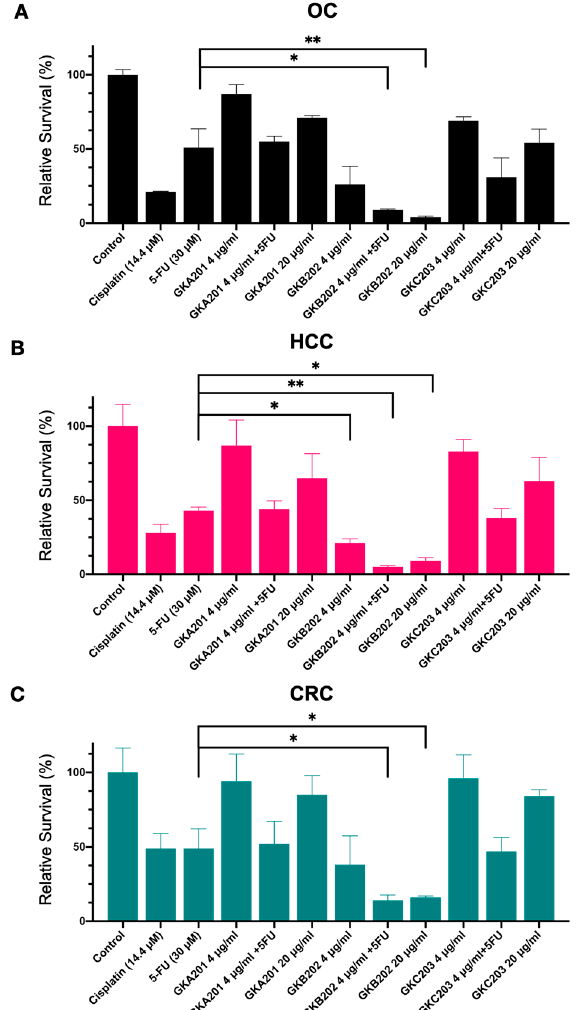
Figure 3. Ex vivo expansion toxicity assay with different purified AC compounds at low and high dosage (4 and 20 µg/mL respectively) in different cancer types. Each patient-derived CTC was tested three times for different assay groups. ( A ) OC: oral cancer, total patients, N = 2; ( B ) HCC: hepatocellular carcinoma, total patients, N = 3; ( C ) CRC: colorectal cancer, total patients N = 3. * Represents a significant difference p < 0.05 and ** represents a significant difference p < 0.01.